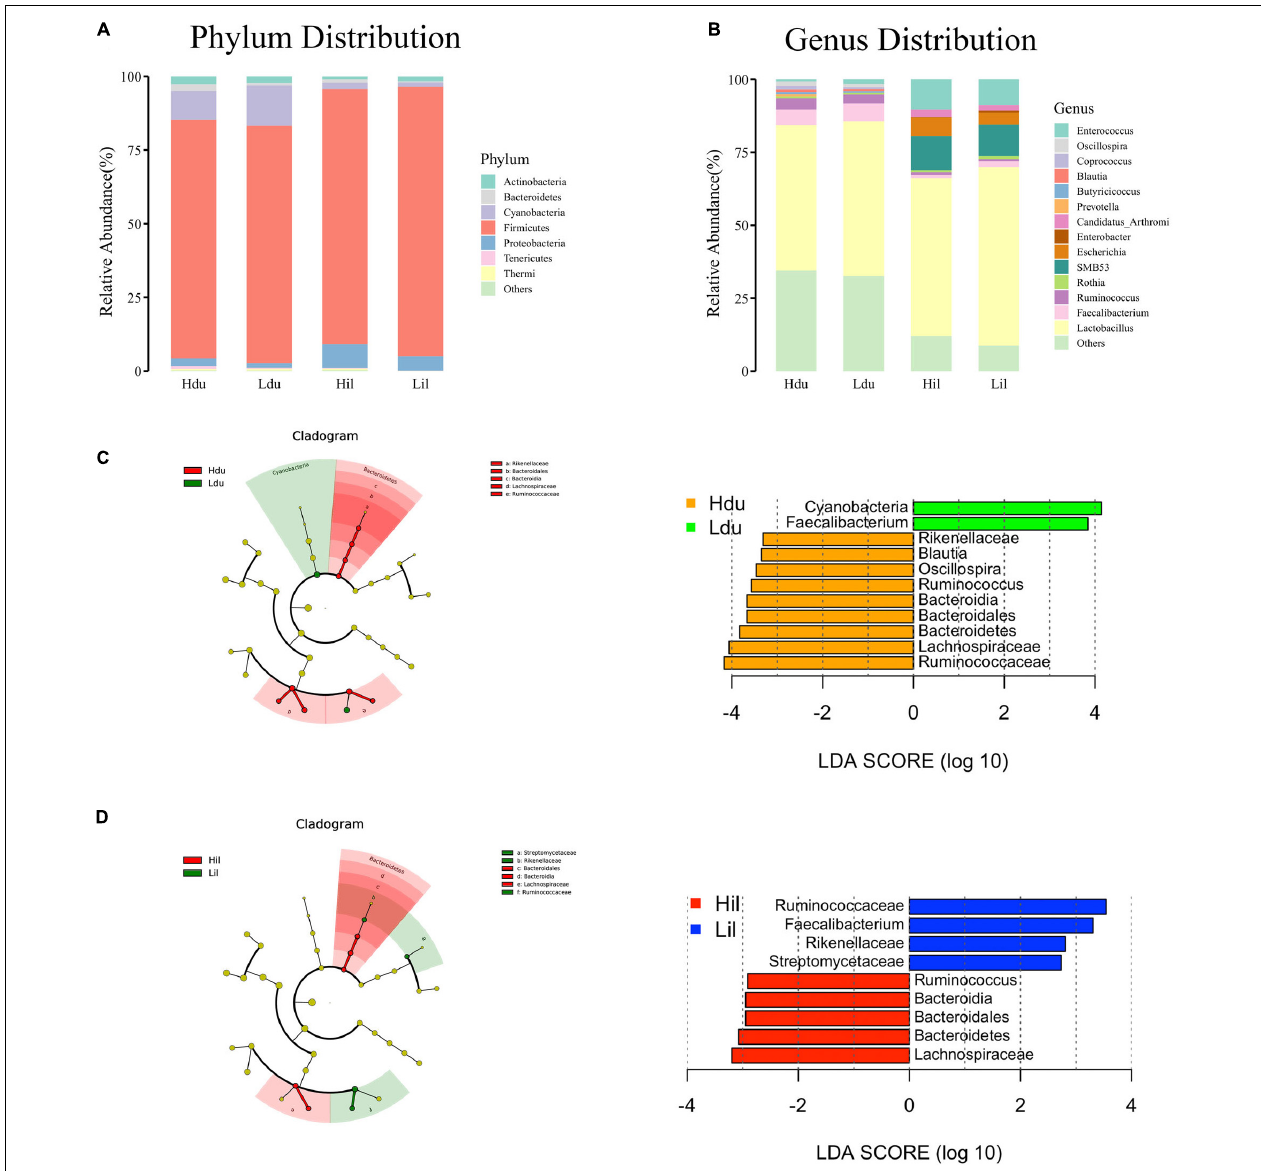
FIGURE 1 | Analysis of microbial community structure of the duodenum and ileum at phylum level (A) and genus level (B) . Each bar represents the average relative abundance of each bacterial taxon in corresponding taxon. Cladogram and LDA value distribution histogram of duodenum (C) and ileum (D) . Hdu and Ldu, HFE group and LFE group of the duodenum. Hil and Lil, HFE group and LFE group of the ileum.